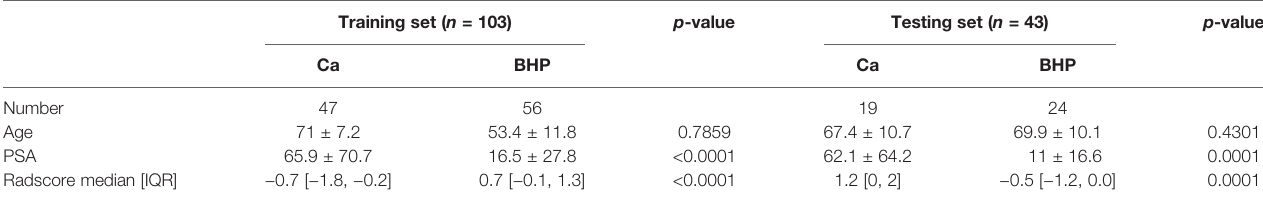
TABLE 1 | Demographic characteristics in the training and validation